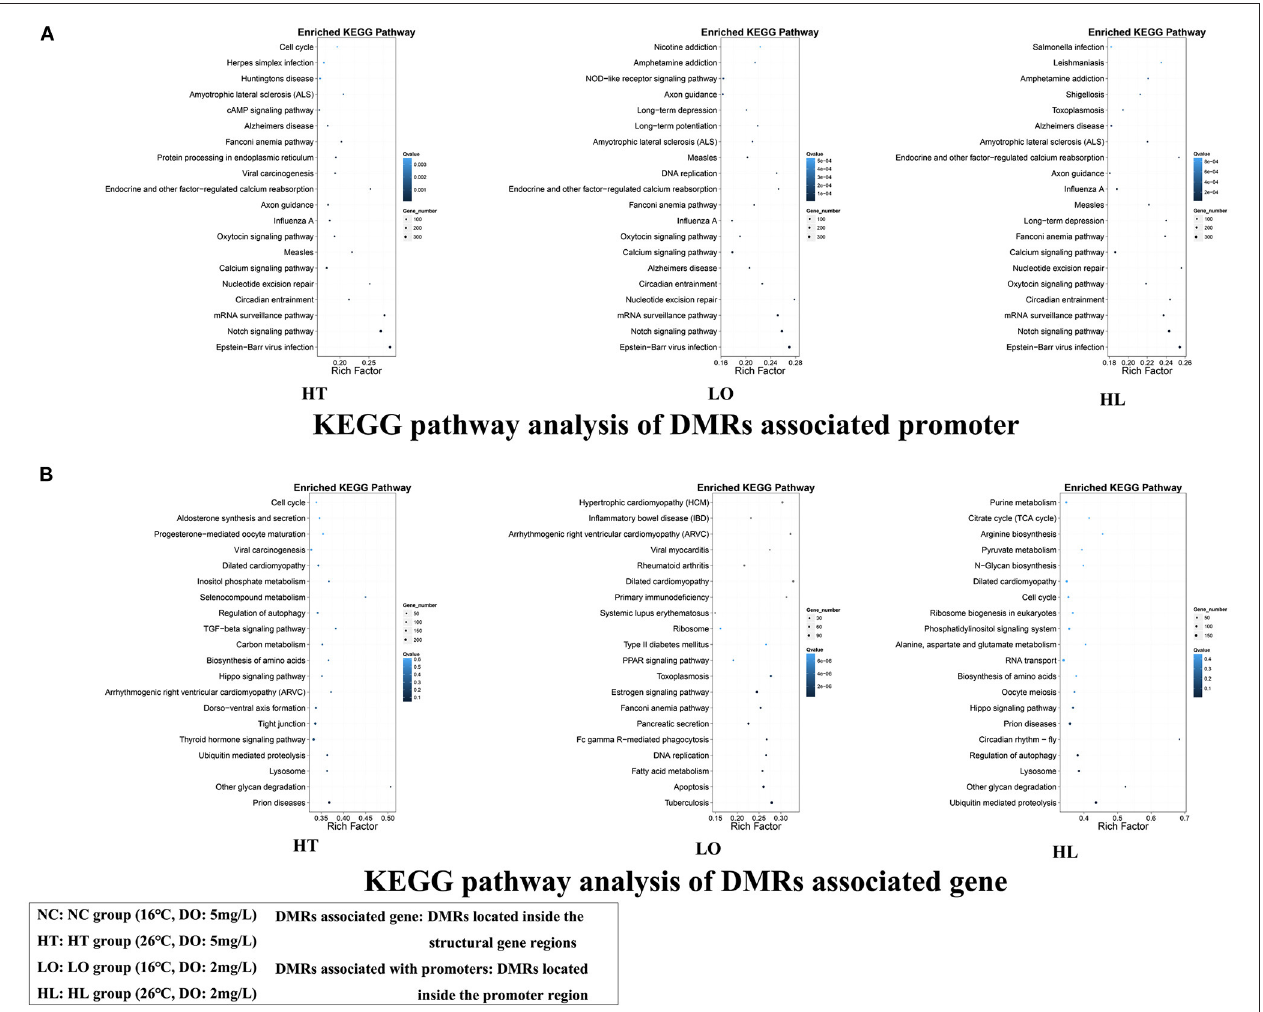
FIGURE 3 | (A) Kyoto Encyclopedia of Genes and Genomes (KEGG) pathway analysis of DMRs associated promoters of HT, LO, and HL groups compared with NC group. (B) KEGG pathway analysis of DMRs associated genes of HT, LO, and HL group compared with NC group. The abscissa represents the proportion of the number of DMRs belonging to a specific KEGG pathway to the whole number of differentially expressed genes, and the ordinate represents the specific KEGG pathway. CpGCRY1bpro-1 and CpGCRY1bpro-2 decreased to a similar extent after